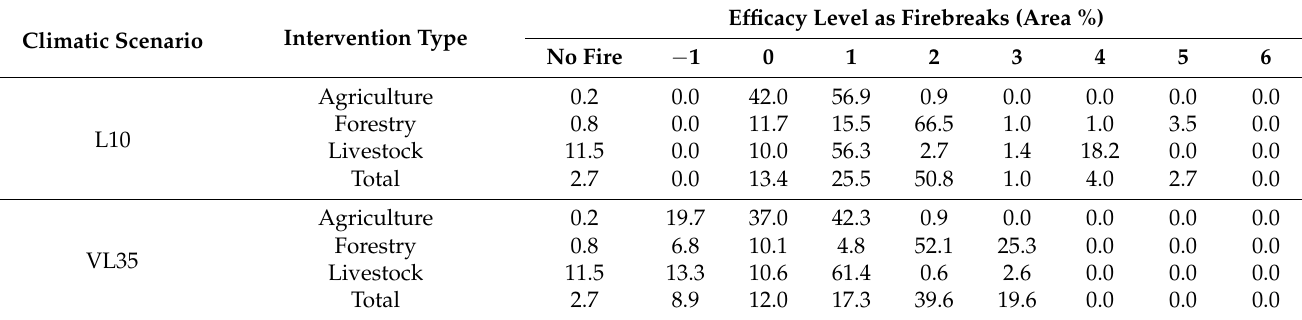
Table 9. Efficacy level of interventions as firebreaks in two climatic